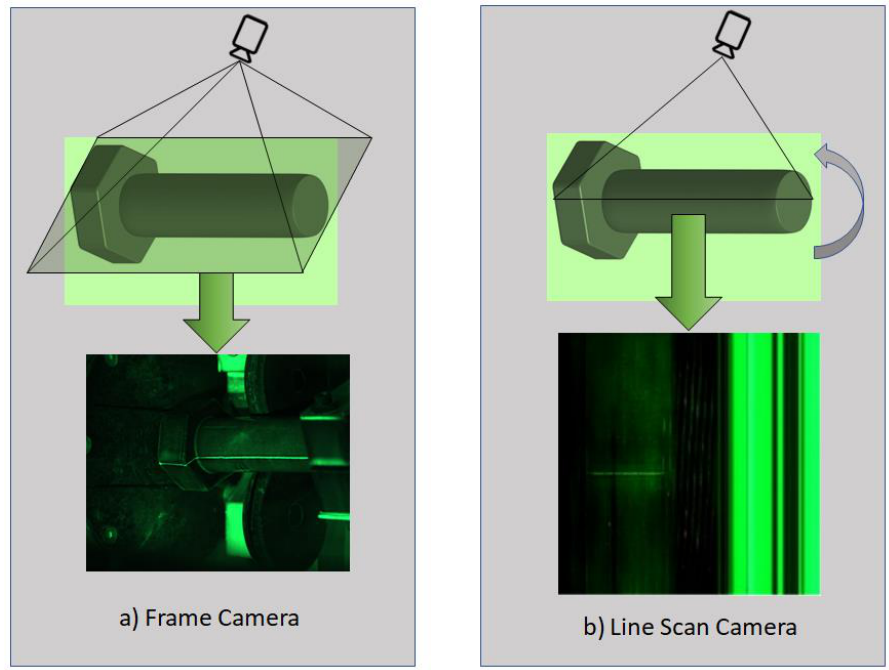
Figure 2. Comparison of ( a ) Frame and ( b ) Line Scan Cameras in terms of how they capture images.